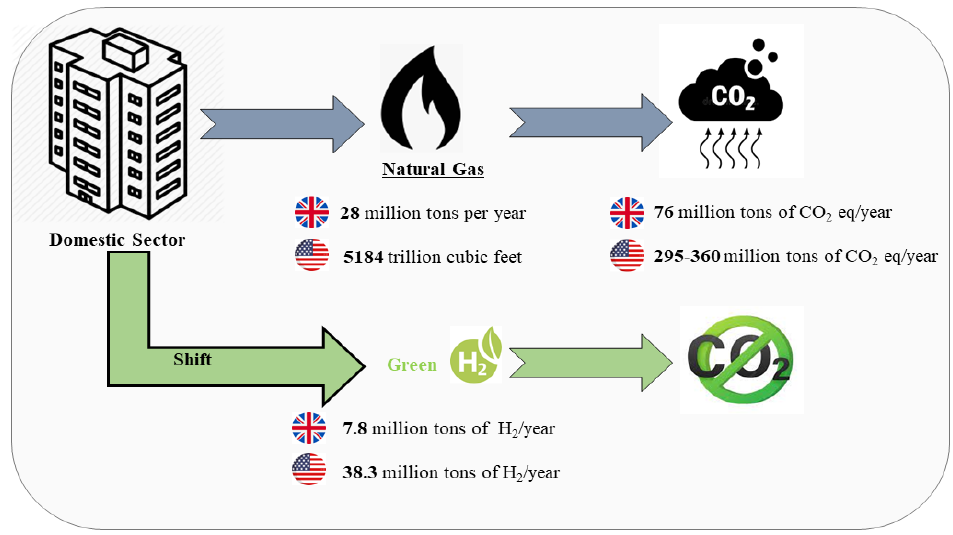
Figure 4. Carbon emissions of natural gas vs. green hydrogen in UK and USA.